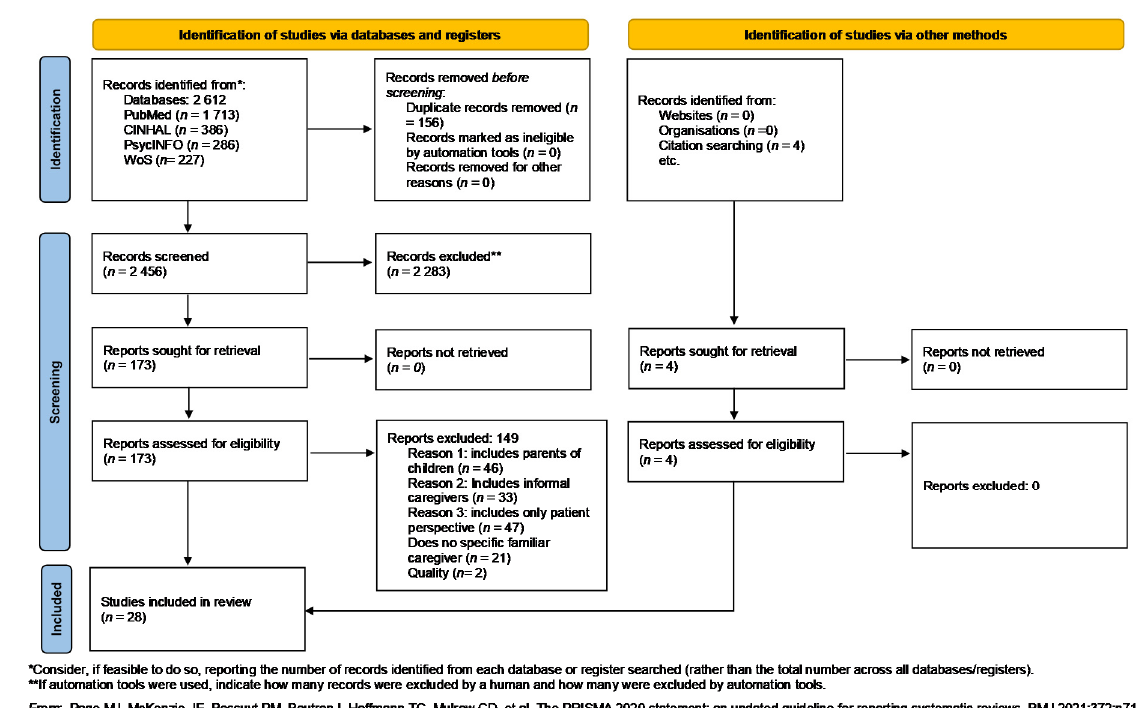
Figure 1. PRISMA 2020 flow diagram [29].